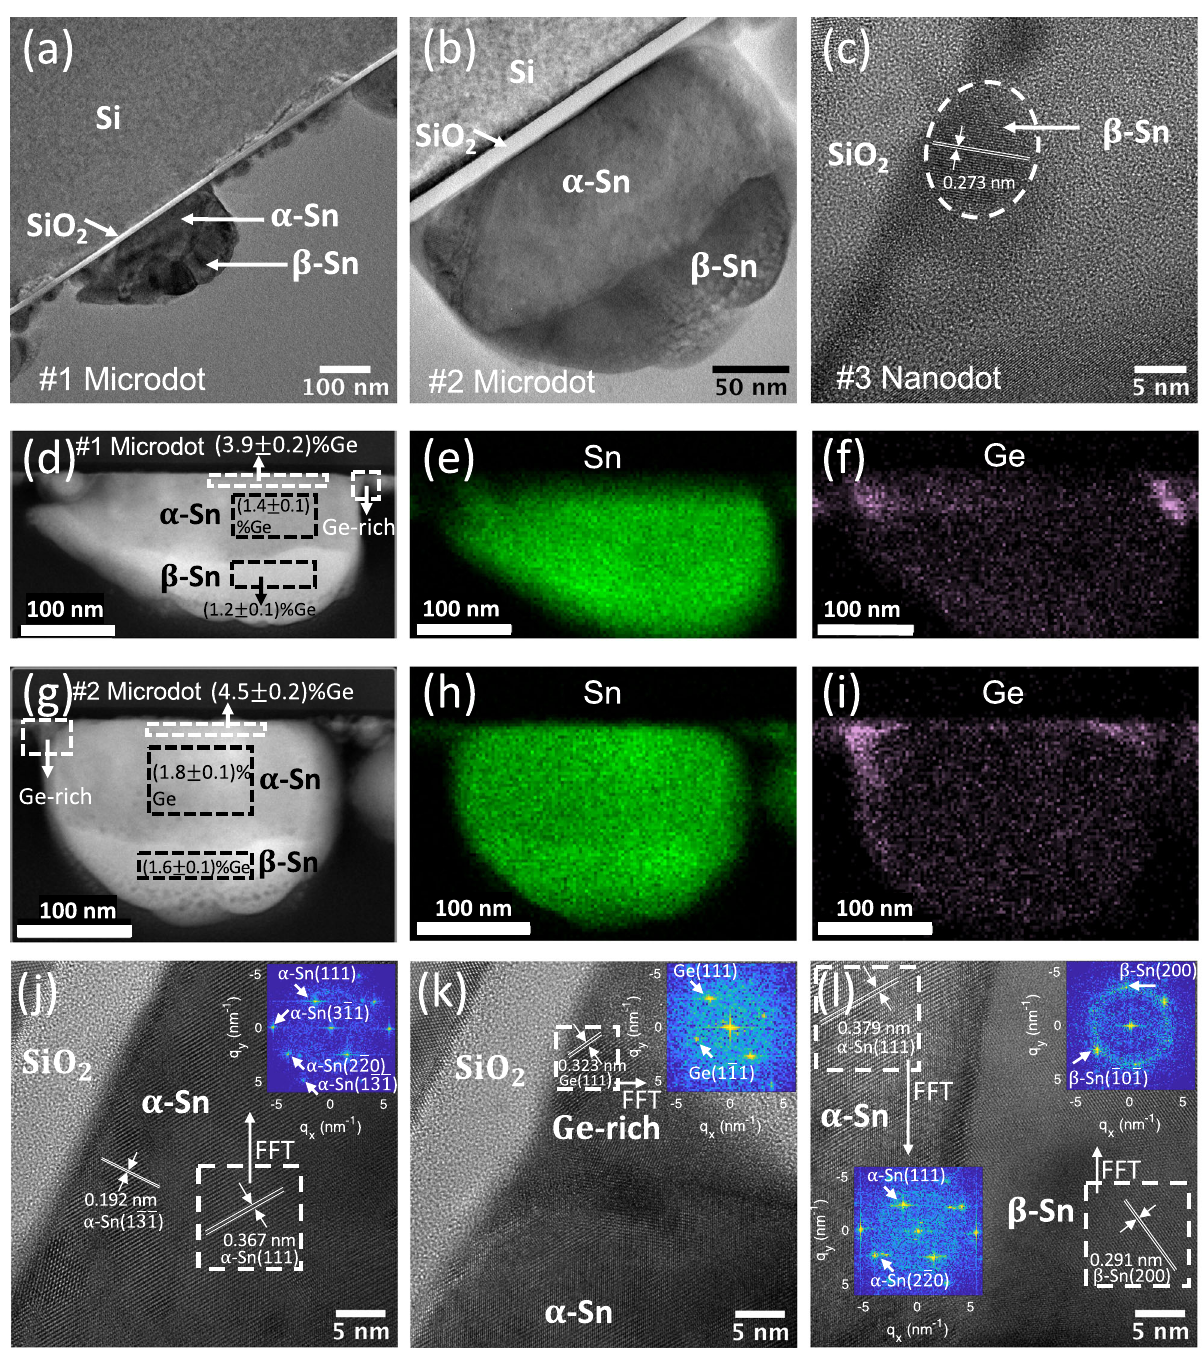
Fig. 4 HRTEM images and EDS analysis of SnGe microdots annealed at 325 °C. a , b Two microdots, both being α -Sn capped with β -Sn. c A small β -Sn dot. d – f are high-angle annular dark- fi eld (HAADF) STEM image and EDS analysis of the microdot in a , while g – i are corresponding analyses of the microdot in b . j – l are HRTEM images of the microdot in a . The insets show FFT of the boxed regions. Panel j corresponds to the α -Sn region at the bottom of the microdot (near SiO 2 interface). Panel k corresponds to the relatively Ge-rich region at the corner of the microdot. Panel l corresponds to the boundary between α -Sn and β -Sn Fig. 6. Figure 6a shows a trapezoid-shaped microdot dominated by a energy. Previous studies show that diamond cubic structures single-crystalline α -Sn grain extending throughout the microdot (corresponding to α -Sn) tend to form facets on top 46 . The HRTEM images in Fig. 6c, f further zoom into a pure α -Sn with ~280-nm-diameter and ~150-nm-thickness. Again, these region and an α / β vertically overlapped region of Fig. 6a, dimensions are ~10x greater than the upper size limit for stable α - respectively. Figure 6d, g convert the boxed regions of c and f Sn nanodots reported earlier. 35 – 37 . In contrast, Fig. 6b shows a dome-shaped microdot dominated by β -Sn. The difference in shape from grayscale into RGB color scale for better visibility. In the between α and β -Sn microdots could due to the different surface pure α -Sn region, Fig. 6d and the corresponding FFT in e show an